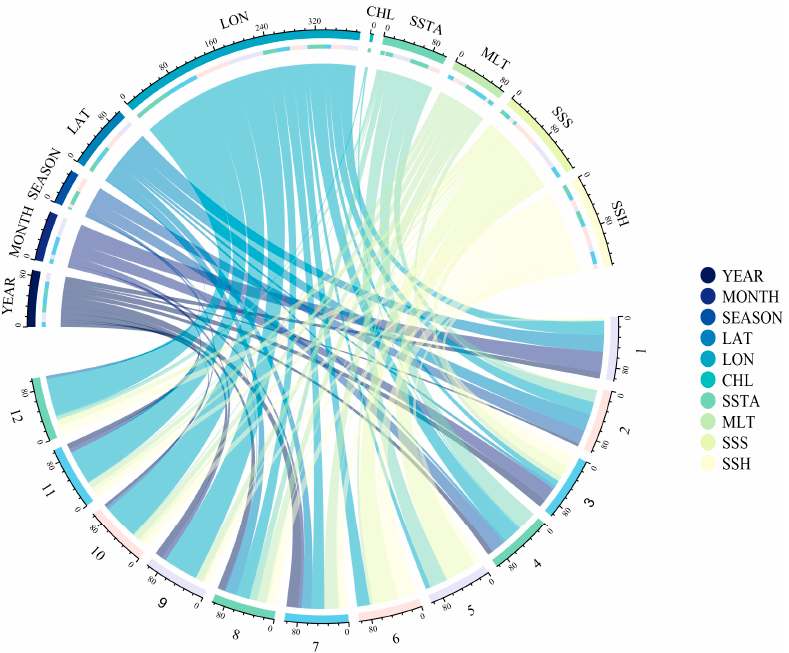
Figure 9. Extent to which each explanatory variable explains the response variable in each of the 12 spatial and temporal settings.